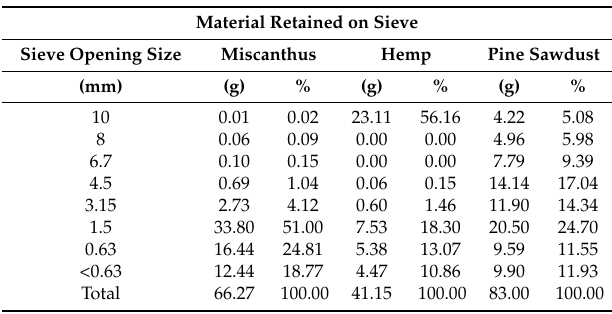
Table 1. Particle size distribution (PSD) of examined materials. Material Retained on